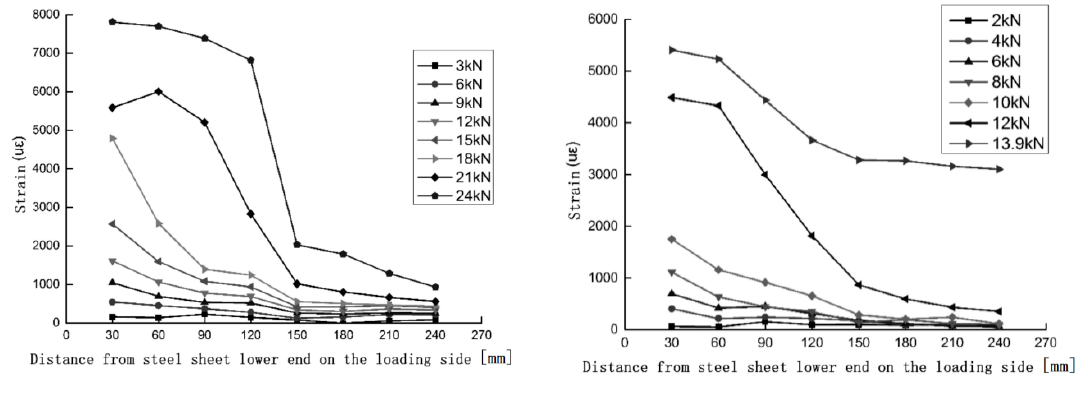
Figure 3. Strain-location curves of specimens ( a ) B-2-1 and ( b ) C-2-1.